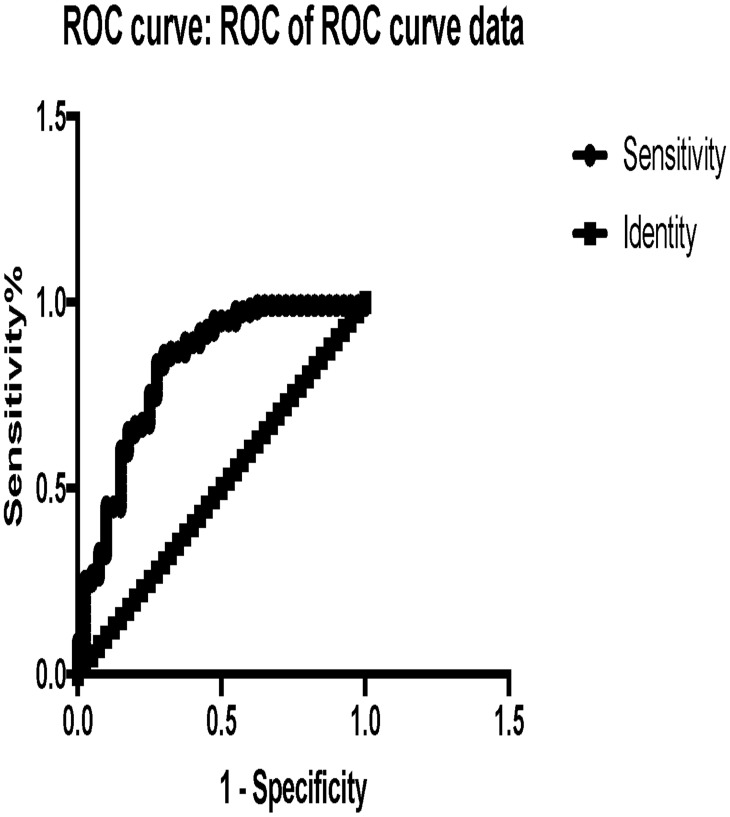
Receiver operating characteristic (ROC) curves to assess the utility of miRNAs to differentiate LN from LNN patients.